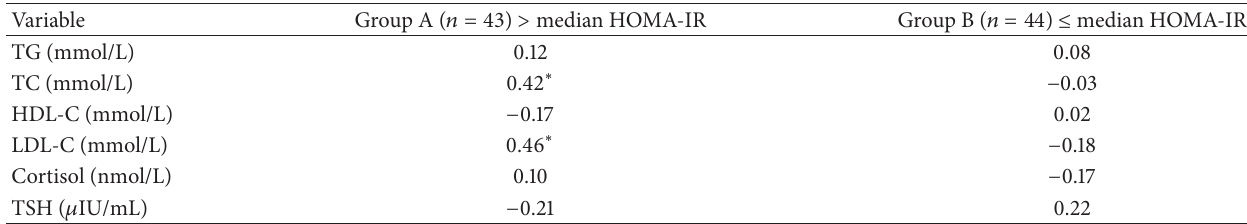
Table 5: Correlation coefficients between HOMA-IR and biochemical variables in